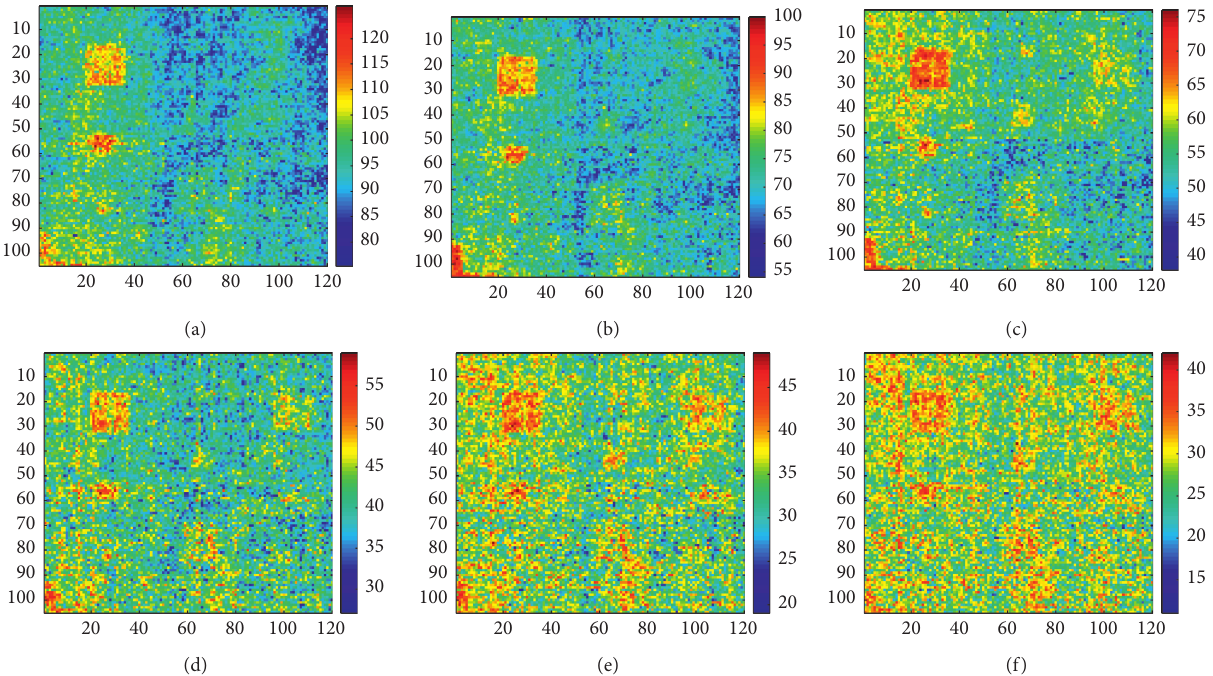
Figure 4: Illustration of defective regions. (a) Img-1. (b) Img-10. (c) Img-20. (d) Img-30. (e) Img-40. (f)